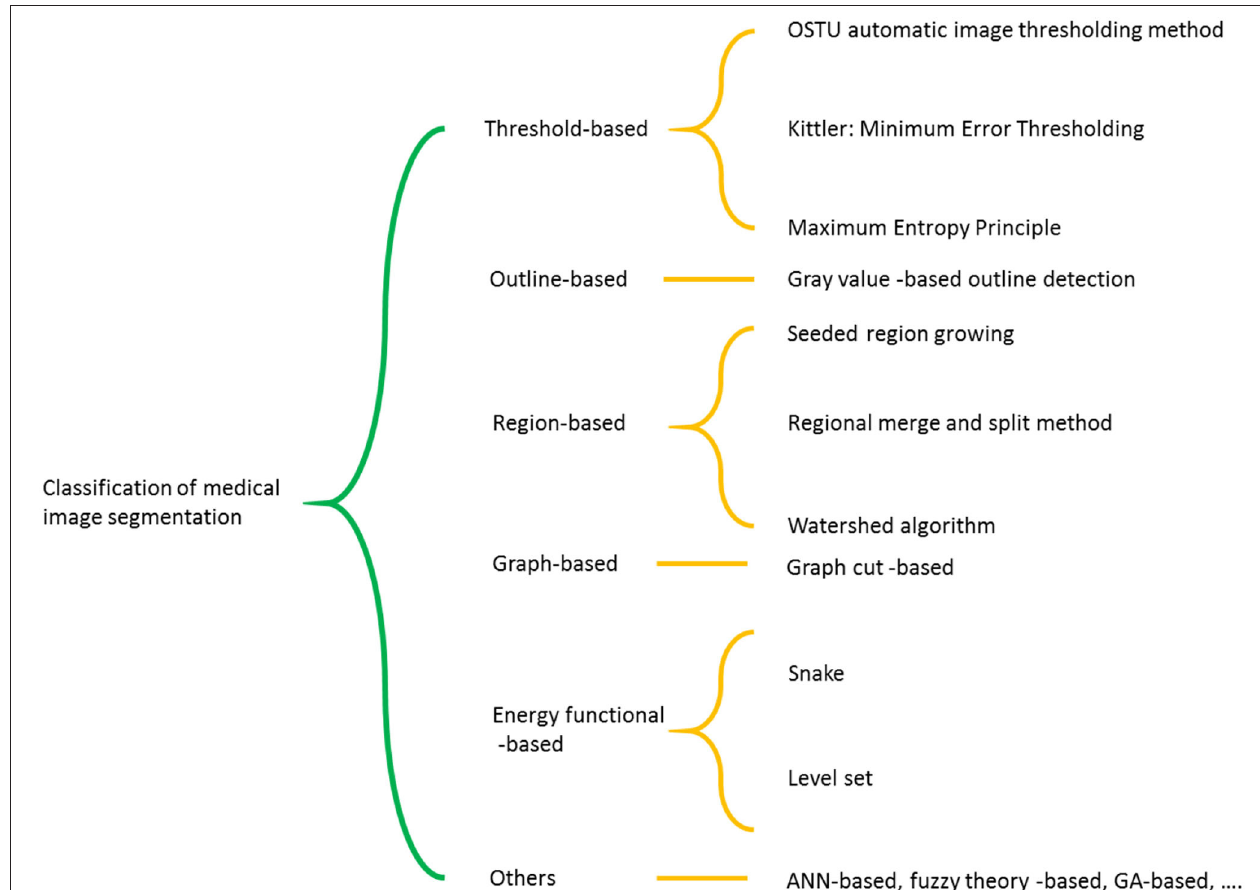
FIGURE 1 | Classification of medical image segmentation